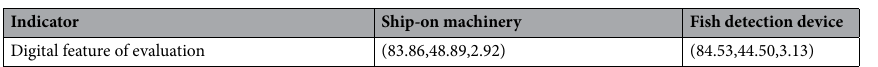
Table 16. Fishing technical indicator expert evaluation cloud model.